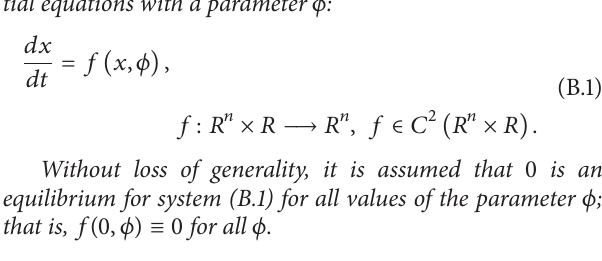
Figure 5: Population size at DFE (a) for 𝑅 𝑀 = 0.61 and EE (b) for 𝑅 𝑀 = 2.09 with Λ = 20000 , 𝜇 = 0.02 , 𝛽 = (0.2, 0.105) , 𝑐 = (8,12) , 𝜎 = 0.525 , 𝛾 = (0.2,0.25) , 𝑝 = 0.17 , 𝜃 = 0.12 , 𝛿 = (5 × 10 −6 ,5 × 10 −8 ) , 𝛼 𝛼 3